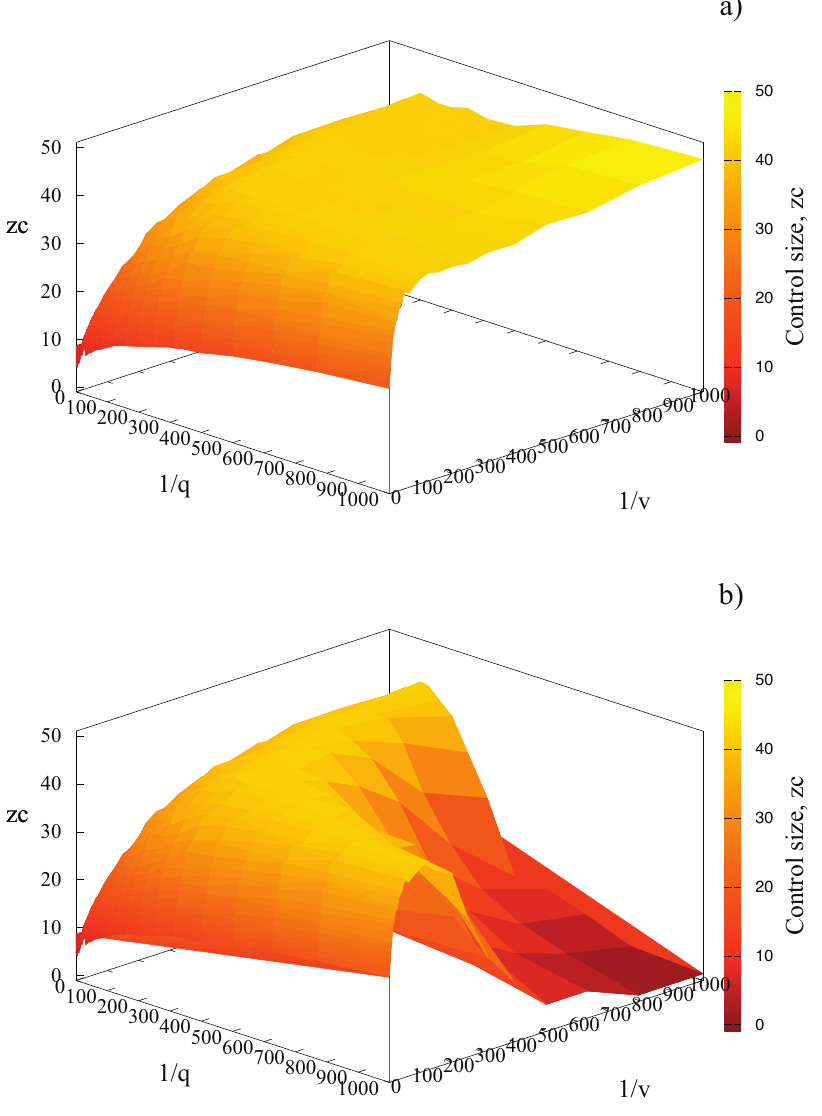
Figure 6. Control neighborhood size as a function of both detection time, t q , and recovery time, t v for c ~ 1 in a) and c ~ 1 : 001 in b). Simulation parameters: f ~ 0 : 1, r ~ 0 : 1, z inf ~ 1, 40 initial foci.